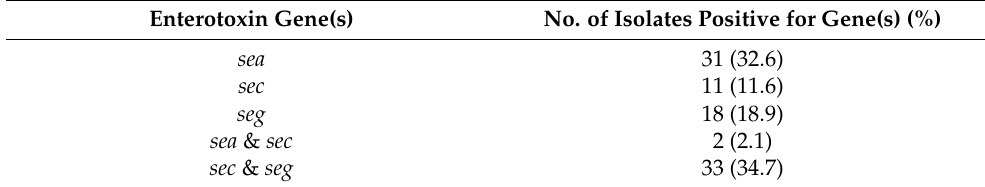
Table 1. Distribution of enterotoxin genes in the 95 S. aureus strains.